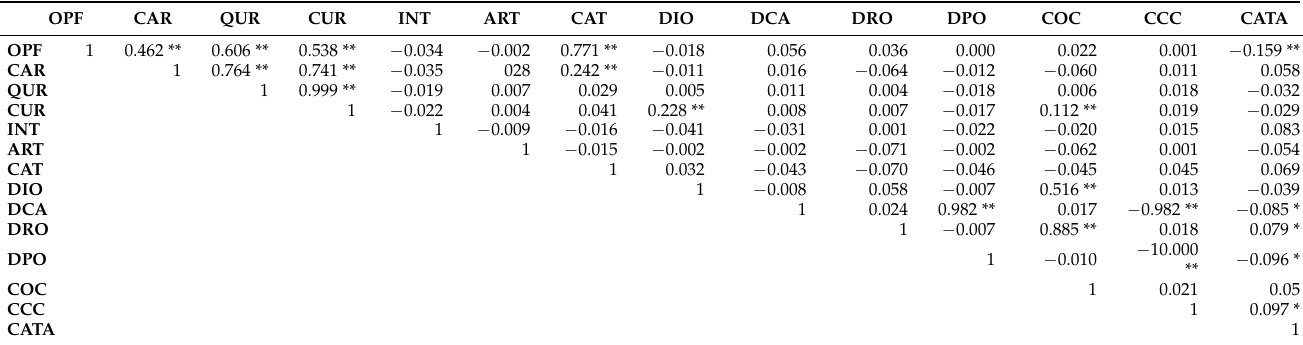
Table 7. Correlation matrix of financial variables for the Czech companies.